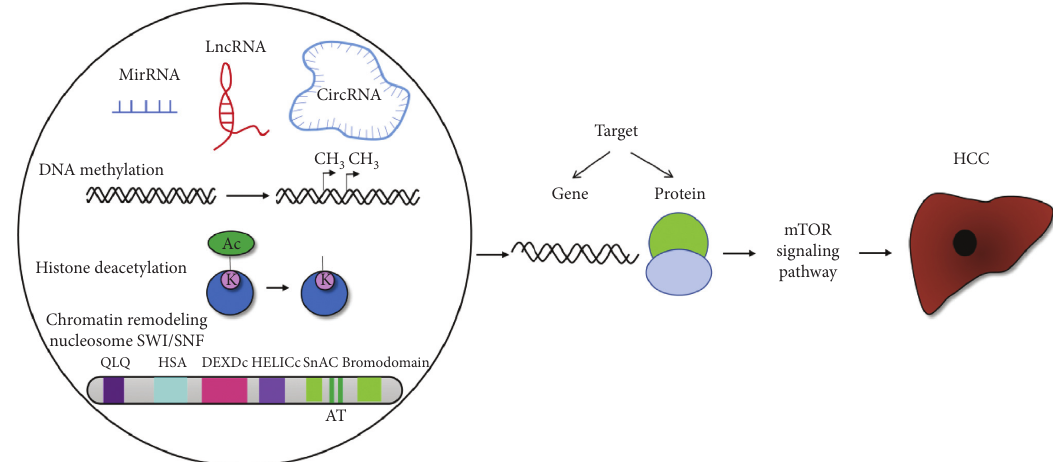
Figure 1: Epigenetic regulation of the mTOR signaling pathway in HCC.